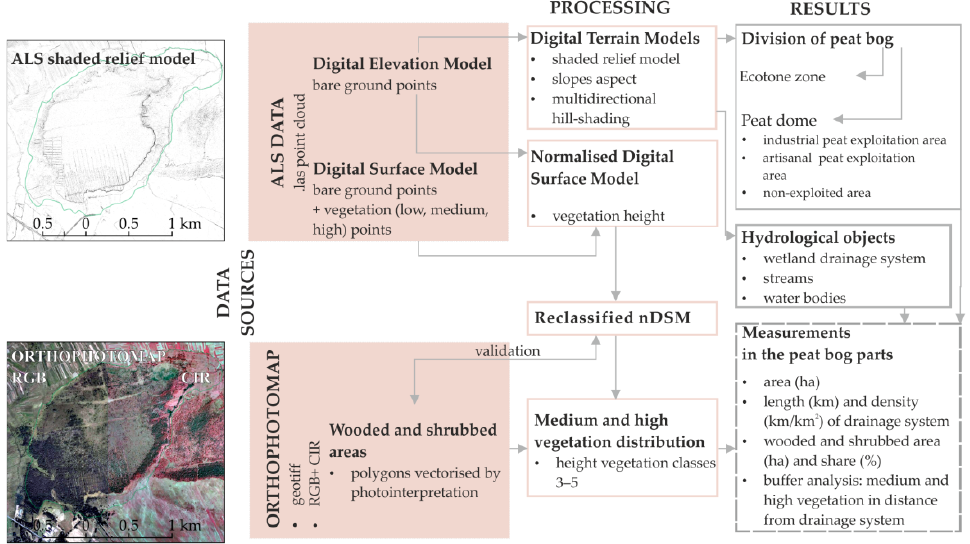
Figure 3. Scheme of workflow in the study.